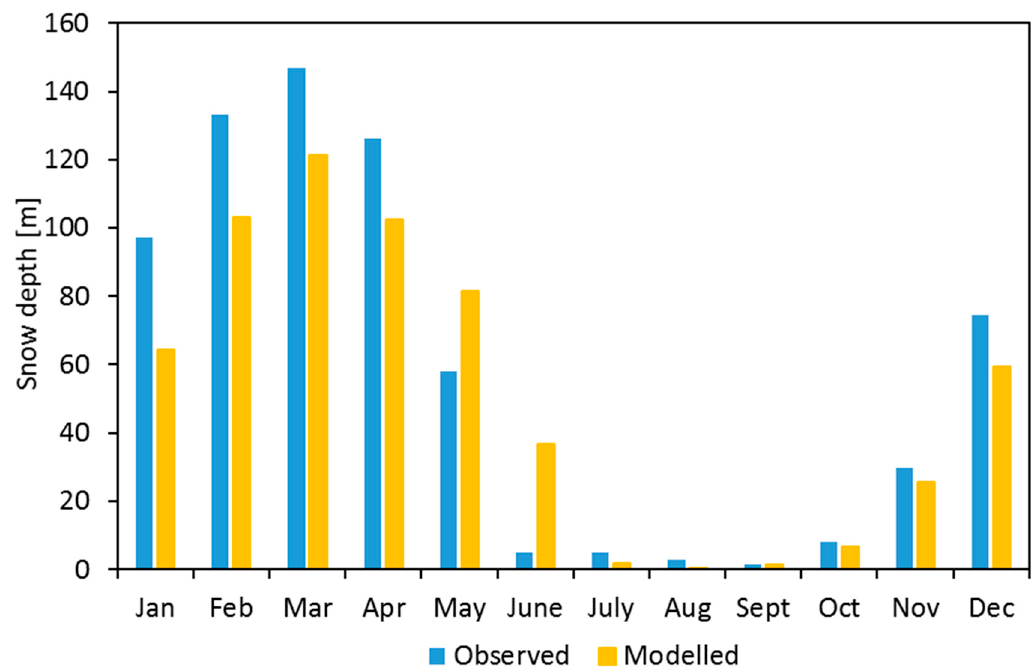
Figure 4. Snow depth from the model vs. snow depth from four AWS stations (average).